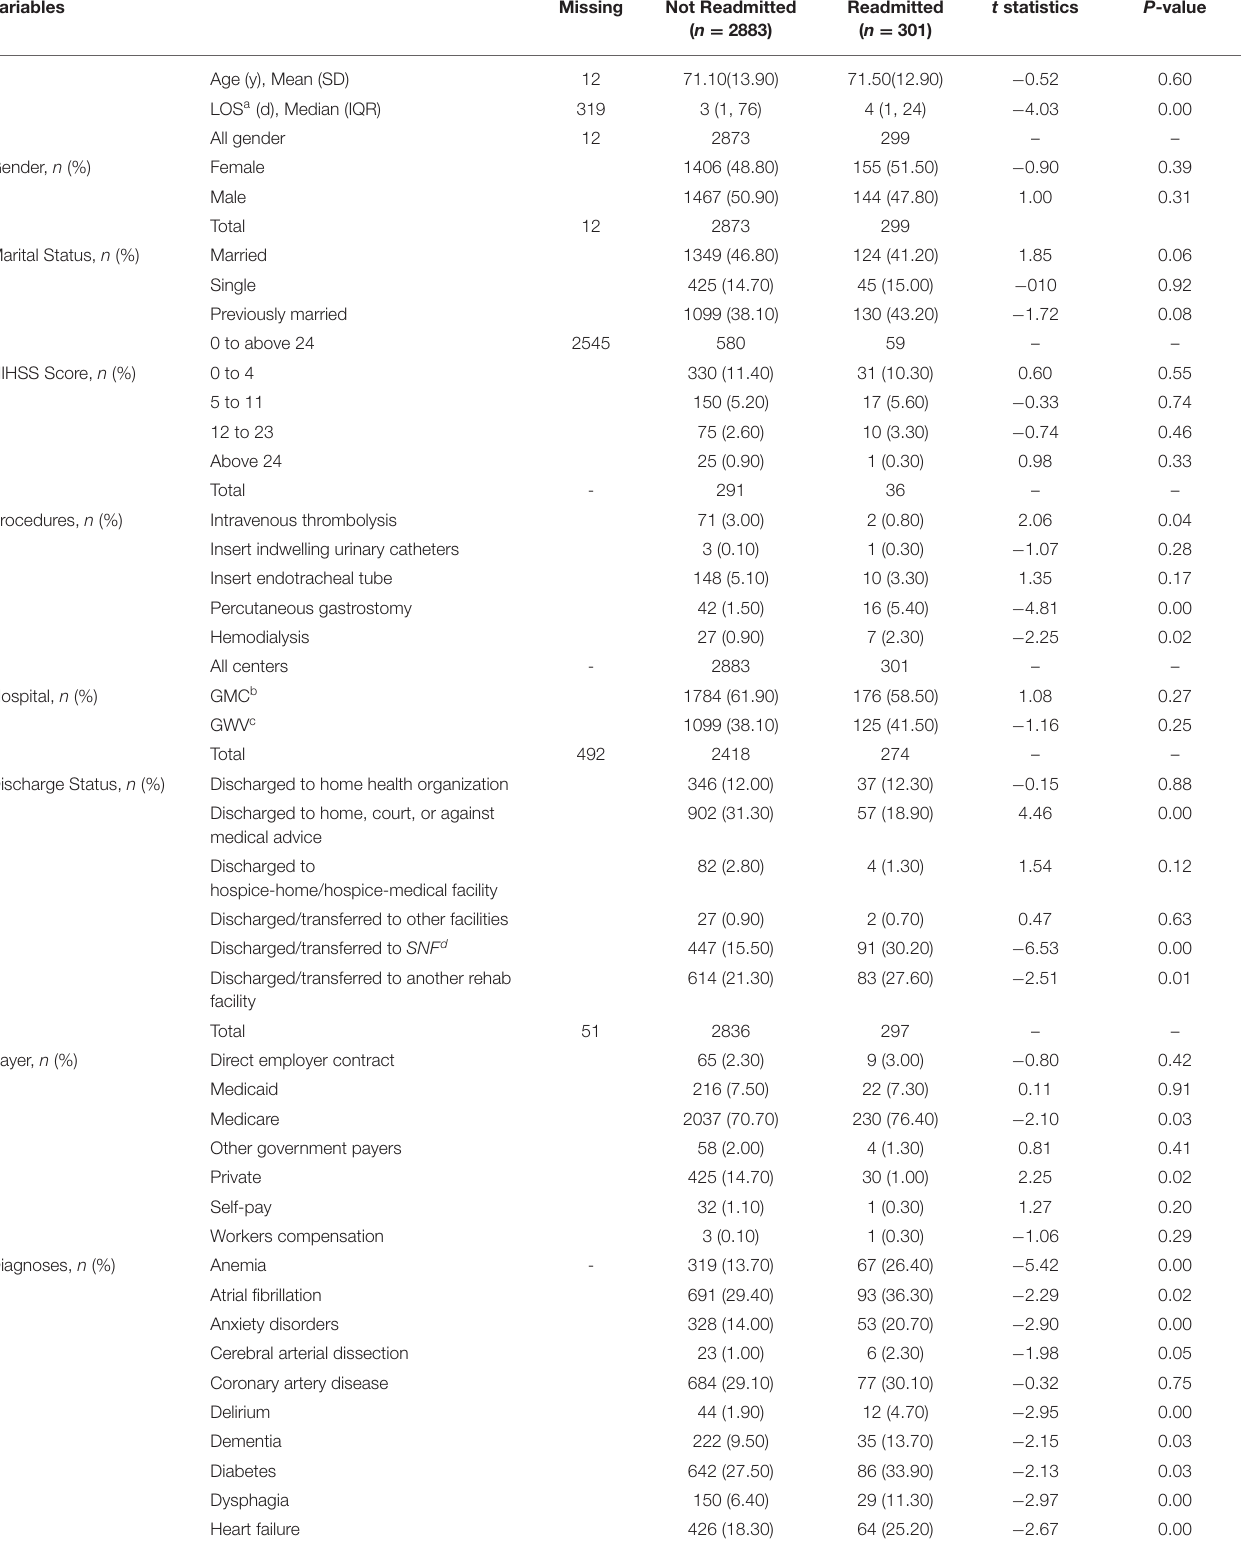
TABLE 1 | Descriptive statistics of